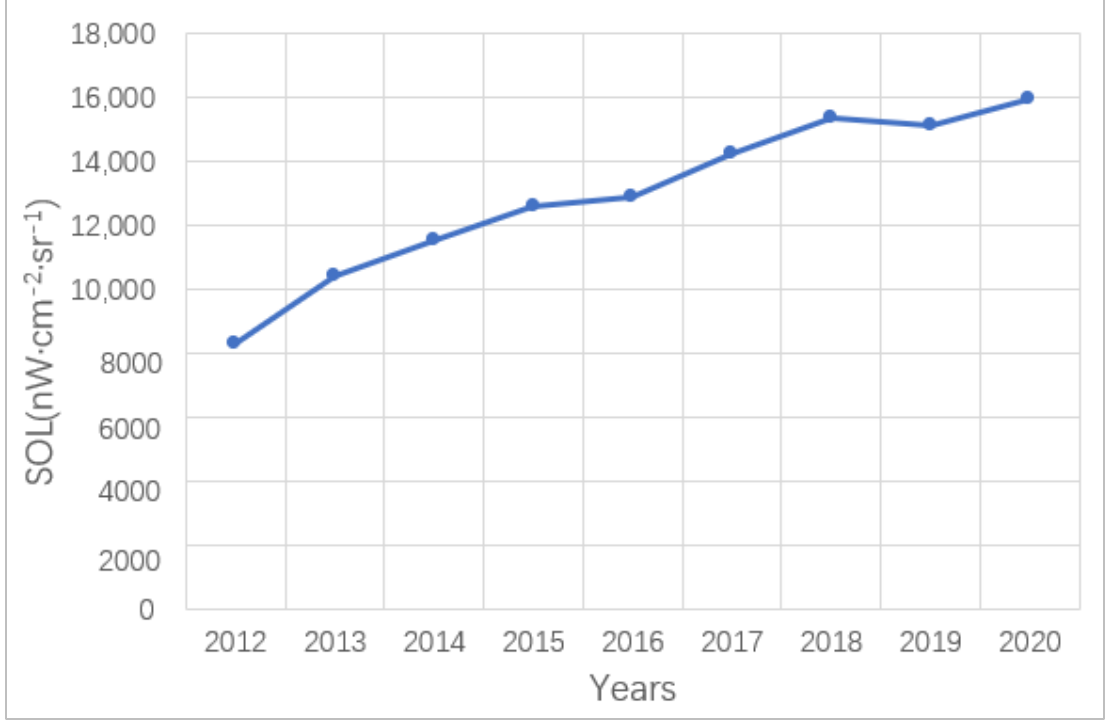
Figure 6. SOL of Rwanda from 2012 to 2020.